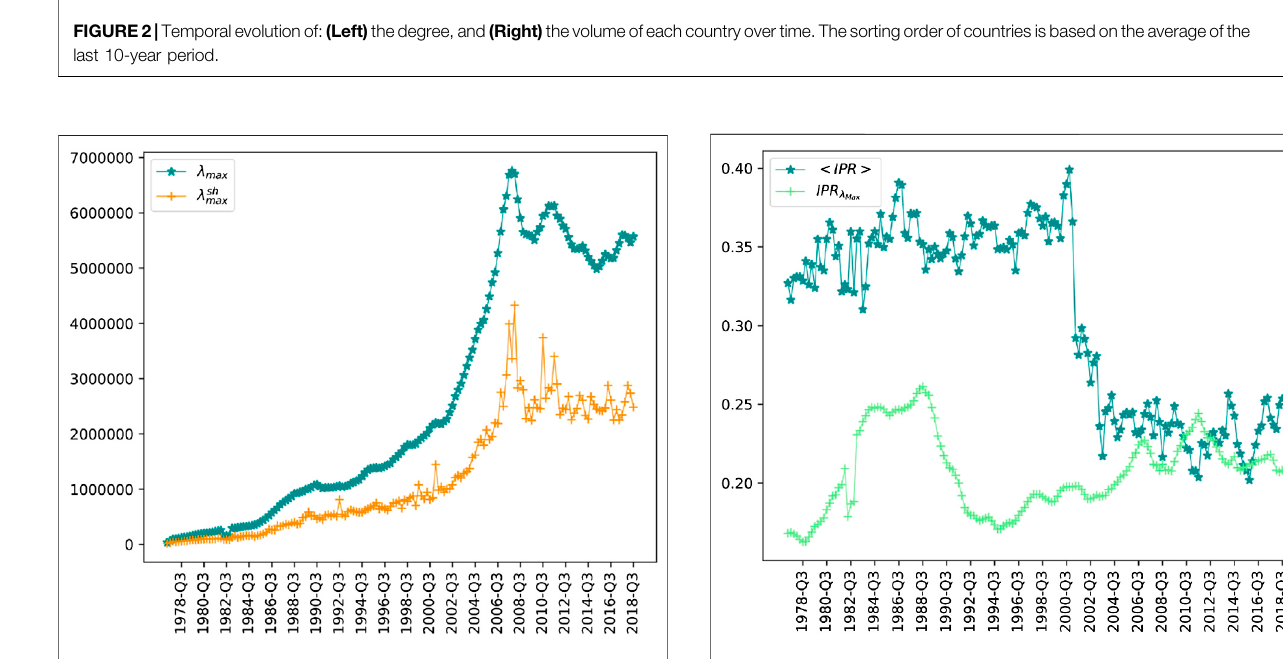
FIGURE 4 | The average of the Inverse participation ratio of all eigenvectors 〈 IPR 〉 and IPR λ has been depicted. The decline of the 〈 IPR 〉 max implies that the contribution of countries in all modes has been increased which can be a consequence of the growth of the connectivity in the banking